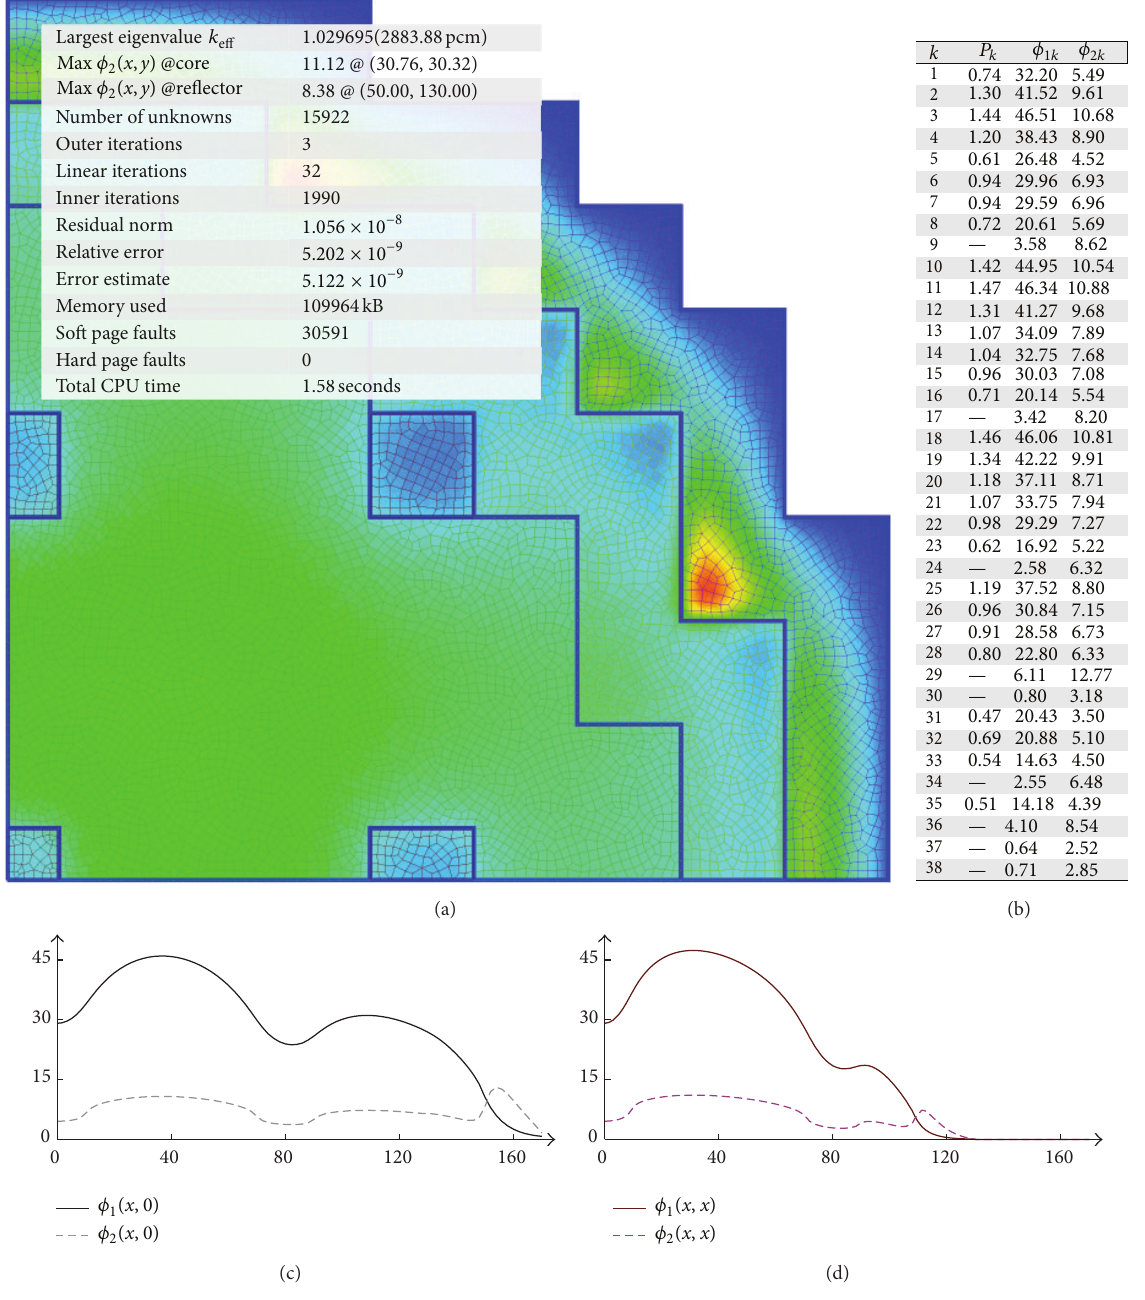
Figure 12: (a) Mesh and thermal flux distribution. (b) Power and fluxes. (c) Flux distribution 𝜙 𝑔 (𝑥,0) along the 𝑥 -axis. (d) Flux distribution (𝑥,𝑥) along the 𝜙 𝑔